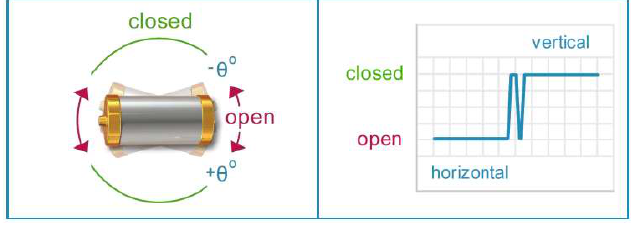
Figure 4. Tilt sensor capsule.